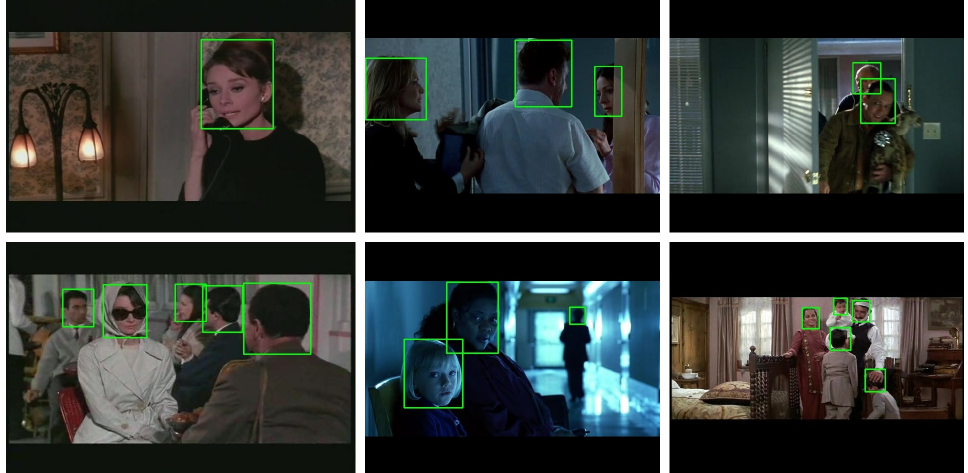
Figure 8. Examples of CRNet’s head detection results on the HollywoodHeads